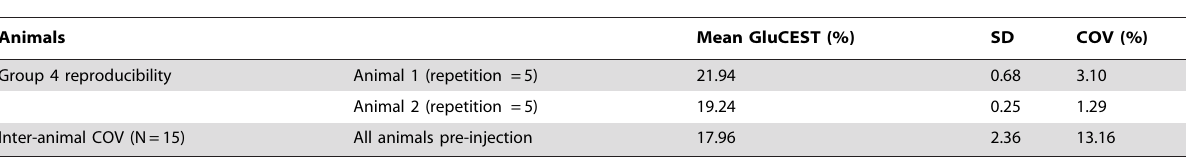
Table 1. Intra and inter- GluCEST coefficient of variance (CV).